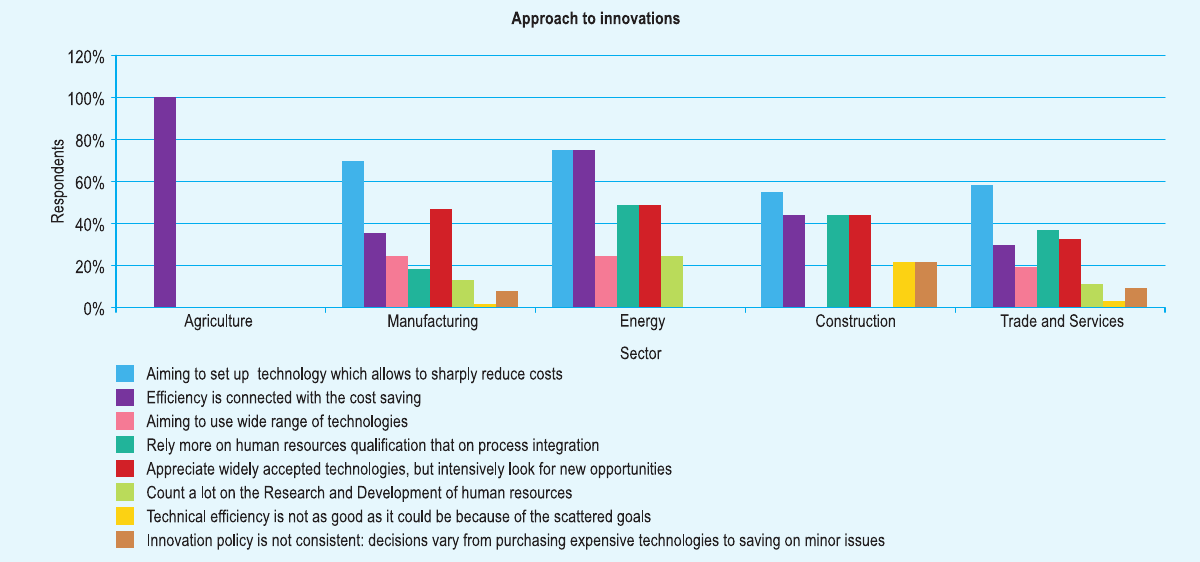
Fig 6 . Innovation strategies of businesses with FDI